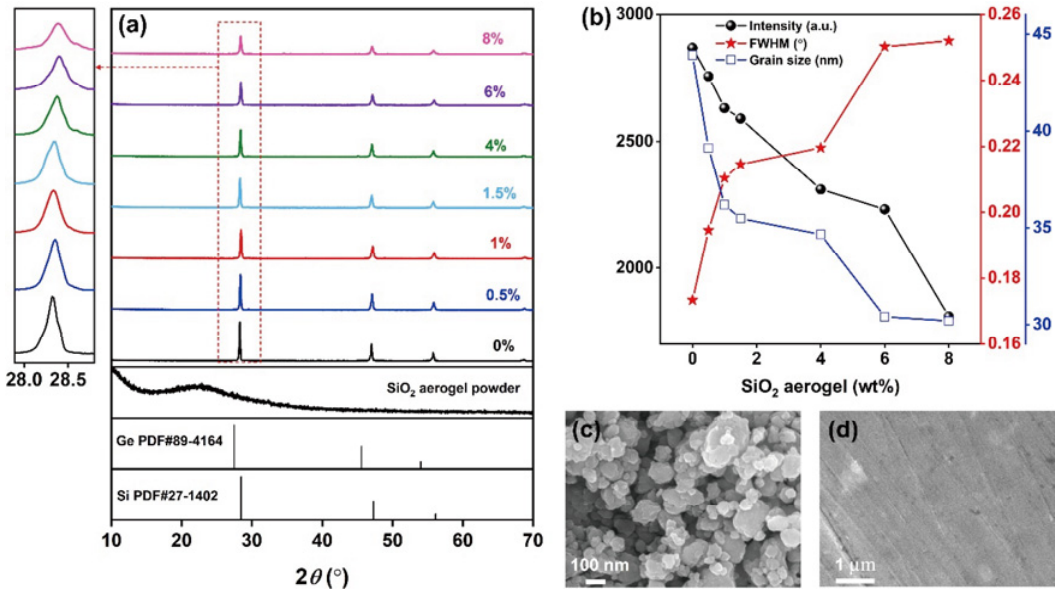
Fig. 3 (a) XRD profiles for series of nominal SiO 2 -composited (0–8 wt% SiO 2 ) samples and raw a-SiO 2 used in this work. (b) SiO 2 -dependent peak intensities, FWHMs, and average grain sizes. SEM images for (c) ~100 nm-composited powder of 1 wt% SiO 2 after BM and (d) 1 wt% SiO 2 pellet after